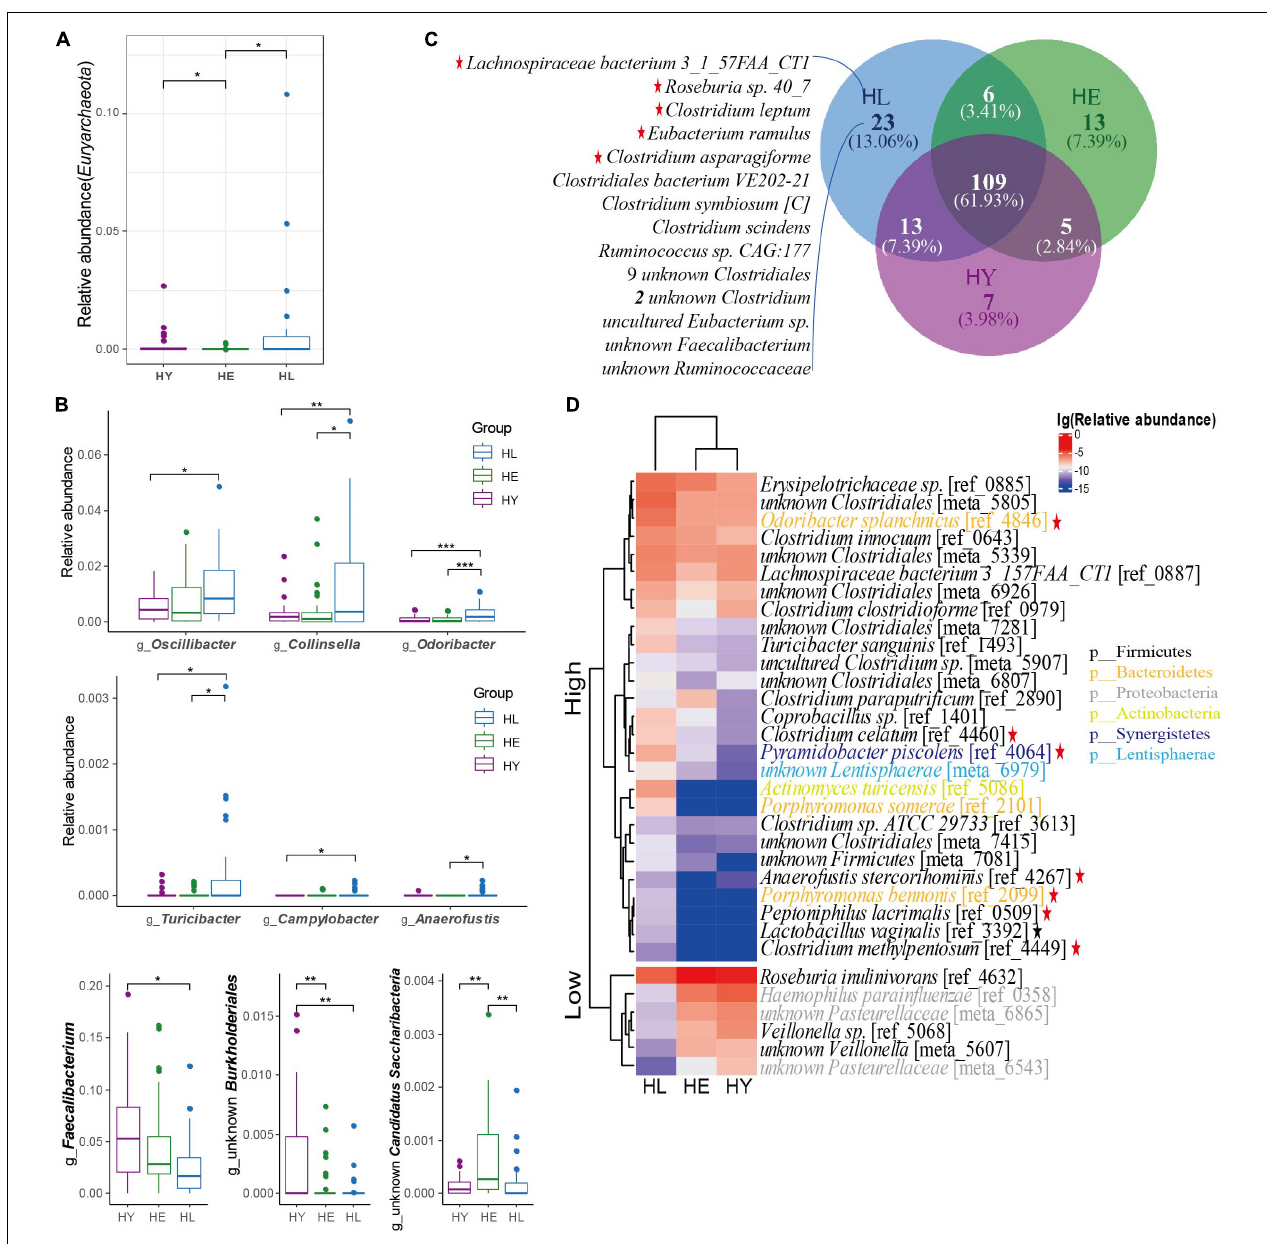
FIGURE 2 | Healthy aging signature of gut microbiota taxonomic components in the three age groups. (A) Relative abundance of the Euryarchaeota phylum. (B) The significantly different genus distributions between the three age groups. (C) Core microbiota species distribution in the three age groups. The “Core microbiota” is defined as the species shared by more than 50% of the individuals in each age group. (D) Heatmap of the relative abundance of species that are significantly different in the three age groups. The base 10 logarithms of relative abundance were used as input, and complete linkage clustering was used. The distance matrix was created by the “Pearson” method. Kruskal-Wallis followed by Dunn’s post hoc multiple-comparison test, P < 0.05. Values that are significantly different are indicated by a bar and asterisks as follows: *, P < 0.05; **, P < 0.01; ***, P < 0.001. Red star: SCFA-producing bacteria; Black star: lactic-producing bacteria. Abbreviations: HL, long-living people; HE, elderly people; HY, young